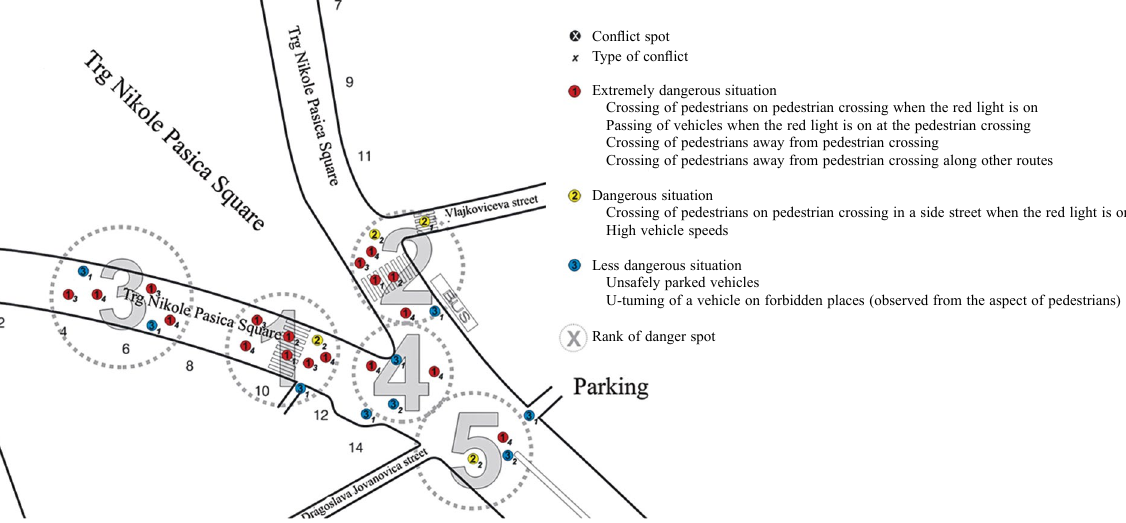
Conflict spot Type of conflict Extremely dangerous situation Crossing of pedestrians on pedestrian crossing when the red light is on Passing of vehicles when the red light is on at the pedestrian crossing Crossing of pedestrians away from pedestrian crossing Crossing of pedestrians away from pedestrian crossing along other routes Dangerous situation Crossing of pedestrians on pedestrian crossing in a side street when the red light is on High vehicle speeds Less dangerous situation Unsafely parked vehicles U-tuming of a vehicle on forbidden places (observed from the aspect of pedestrians) Rank of danger